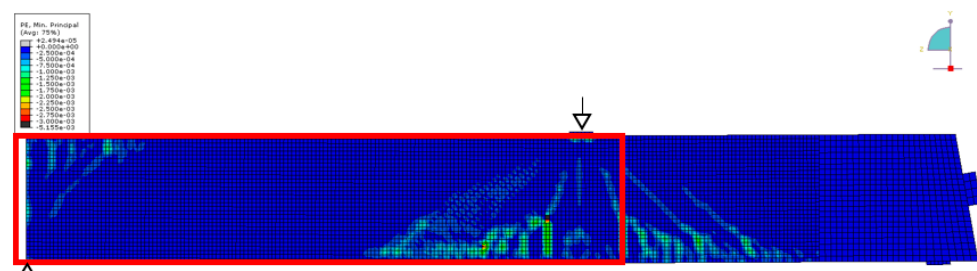
Figure 14. Girder DLT 1.3: Simulation of main compressive strain at 1250 kN load. Abaqus, M. Herbrand, RWTH Aachen University. Red rectangle: area displayed in Figure 12.